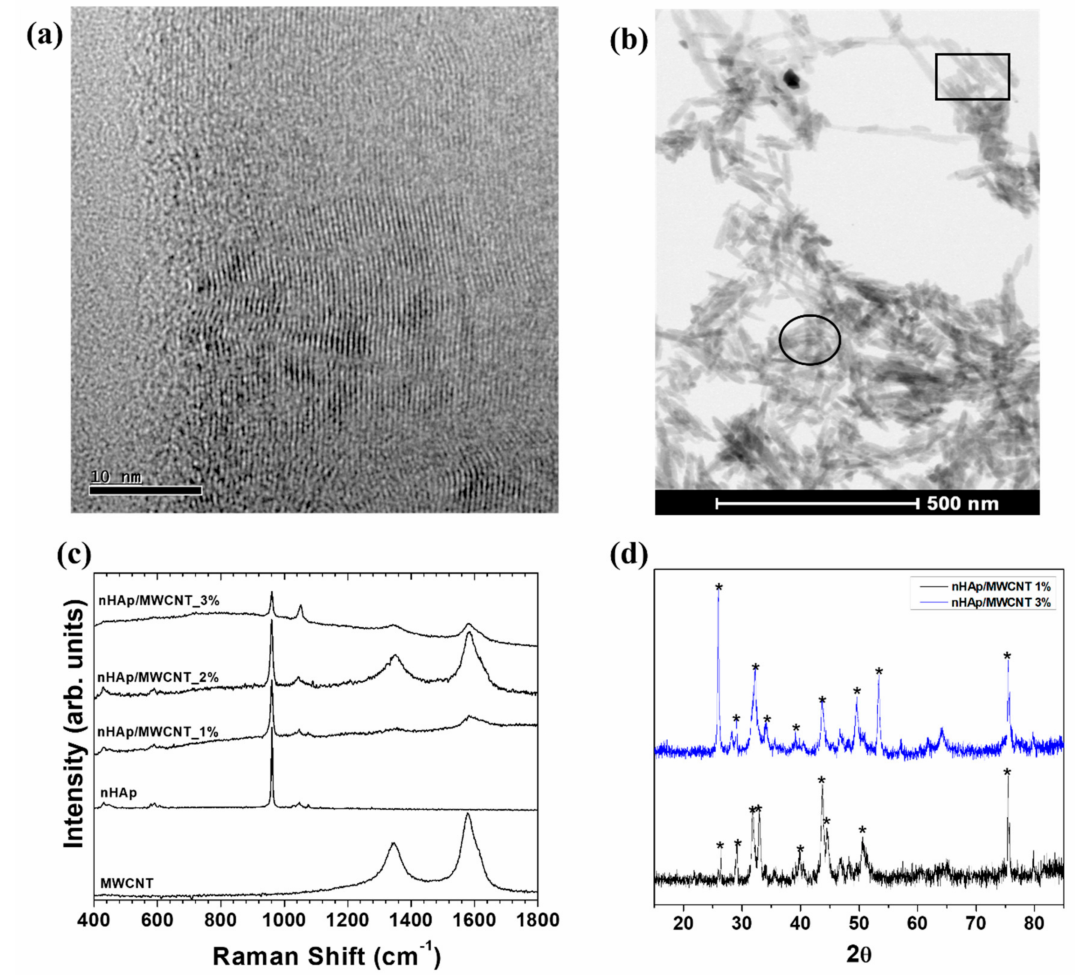
Figure 1. Characterization of MWCNT, nHAp/MWCNT composites and 316L stainless steel alloys covered by nHAp/MWCNT composites. ( a ) High-resolution transmission electron microscopy (HR-TEM) illustrates the internal structure of MWCNT showing the walls. ( b ) Scanning electron microscopy (SEM) identified typical needle-like crystals deposited onto MWCNT. The square illustrates the MWCNT covered by nHAp crystals and the circle illustrates a region containing pure nHAp crystals. ( c ) Raman spectra collected from 316L stainless steel were consistent with those of the nHAp structure, and vibrational modes associated to the carbonate and phosphate phase were identified. The D and G band from the MWCNT are also identified. ( d ) XRD collected from the top of electrodeposited nHAp/MWCNT films. Clearly, the nHAp phase was correctly indexed using a JCPDS card: 024-0033 (identified using